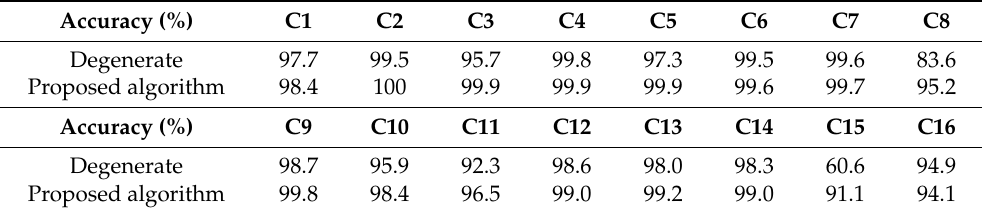
Table 6. The classification accuracy of the 16 categories on the Salinas